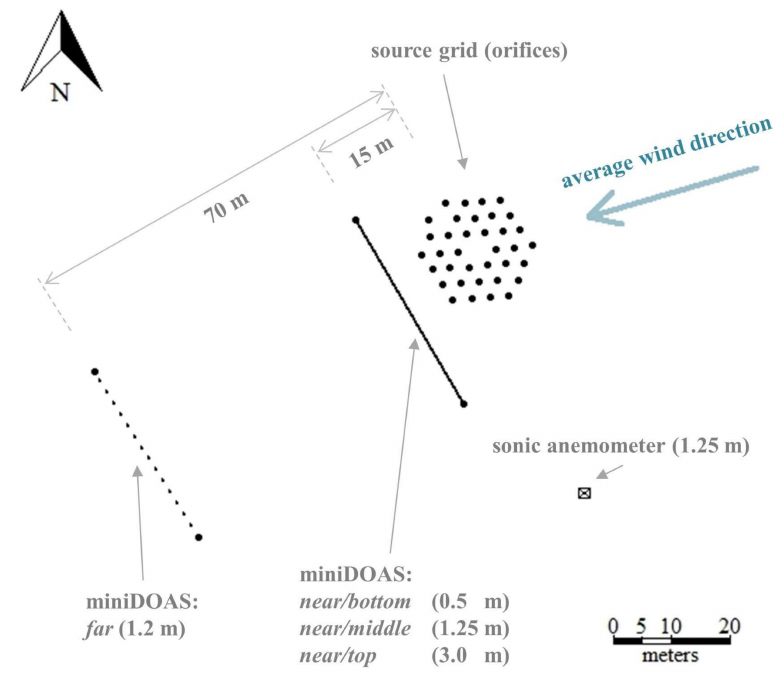
Figure 4. Position of the source (orifices) and the instruments during the artificial source release experiment as measured with the GPS device. Three miniDOAS ( near / top , near / middle , and near / bottom ) were located close to the artificial source at three different heights, one miniDOAS was located further downwind ( far ). The average wind direction during the release experiment is indicated by the blue